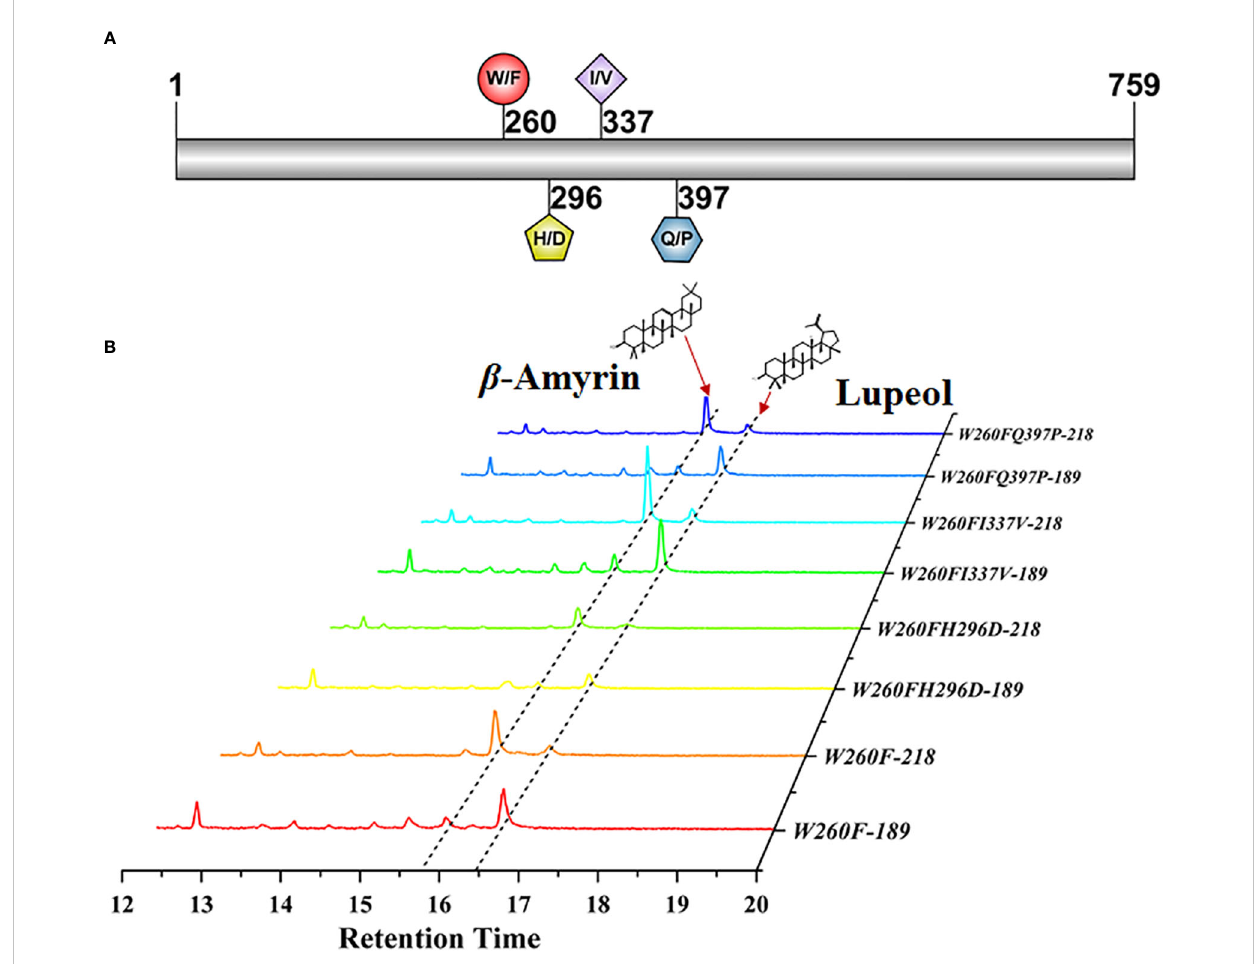
FIGURE 4 Functional characterization of the directional mutant protein W260F, W260FI337V, W260FH296D, and W260FQ397P. (A) Diagram of the mutant sites of PcAS . (B) GC – MS analysis of mutant protein expressed yeast extraction. The 218 and 189 ion counts of b -amyrin and lupeol are shown,